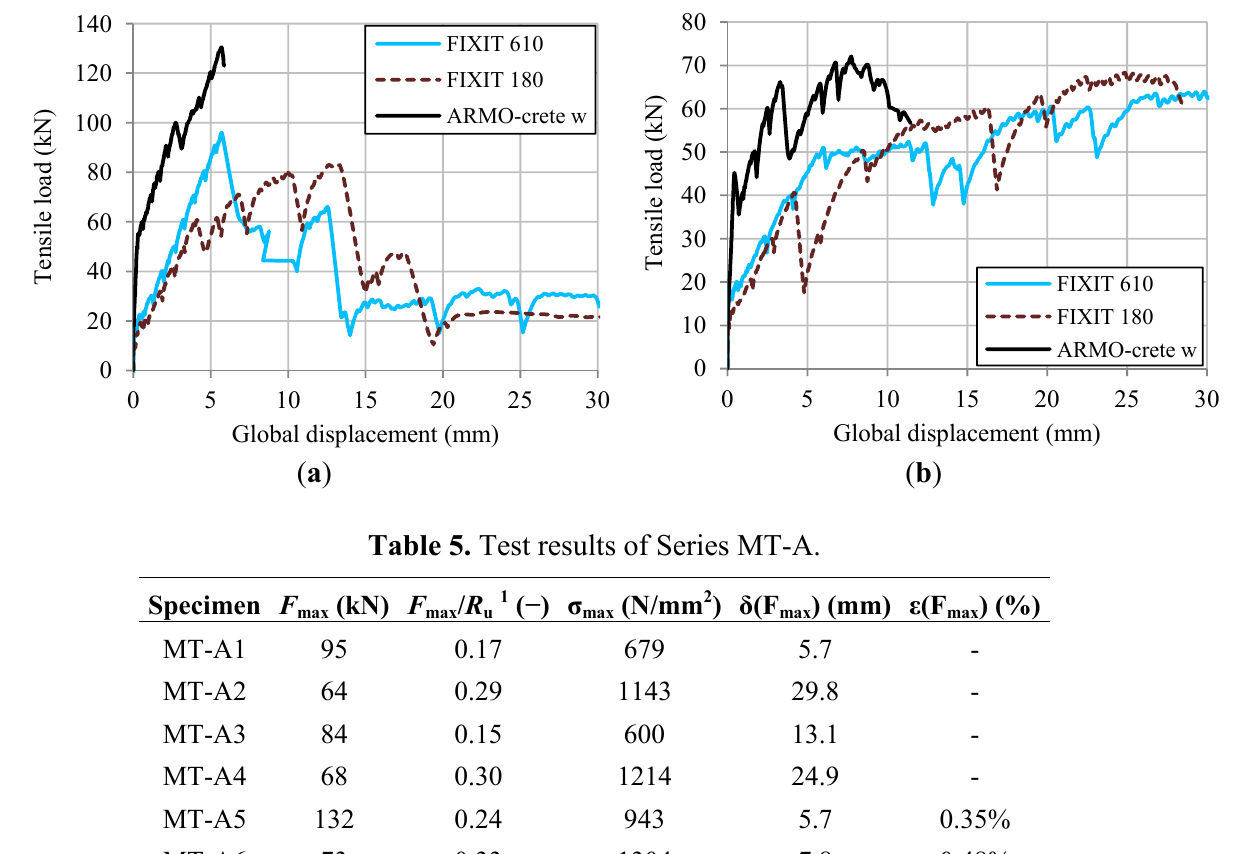
Figure 9. Load-displacement curves. ( a ) Specimens MT-A1/A3/A5 with mesh L500; and ( b ) Specimens MT-A2/A4/A6 with mesh L200.